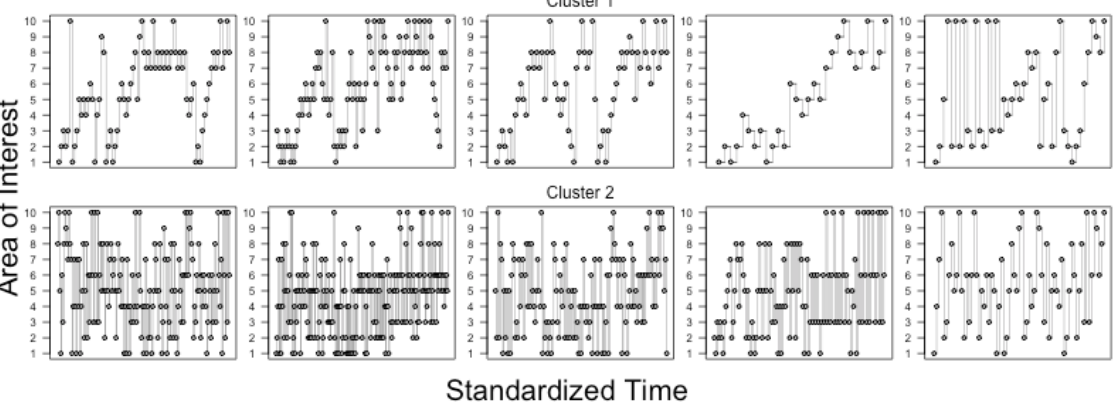
Figure 9. Top row shows five scanpaths that have been assigned to cluster 1, bottom row shows five scanpaths that have been assigned to cluster 2 by all three clustering methods. Repeated fixations are